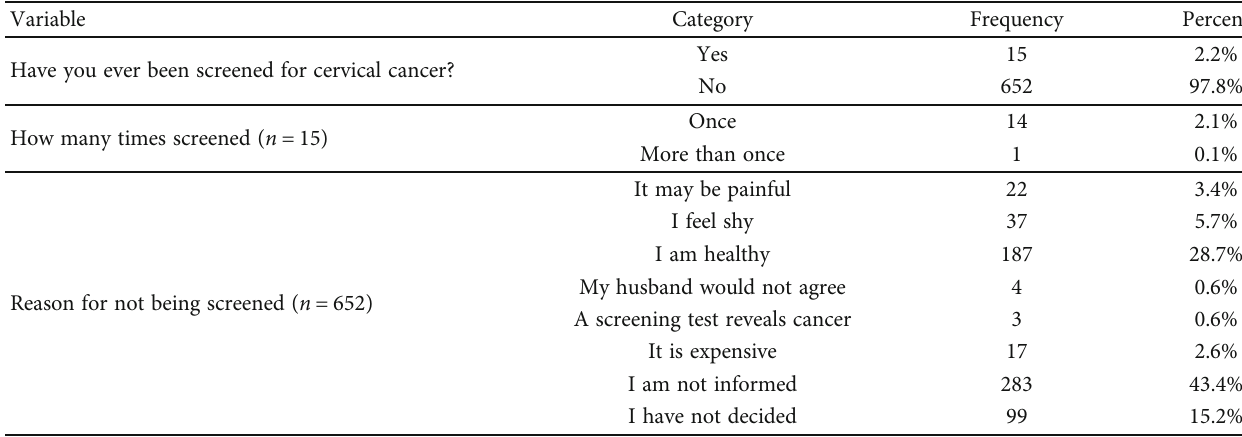
Reason for not being screened ( n = 652 )